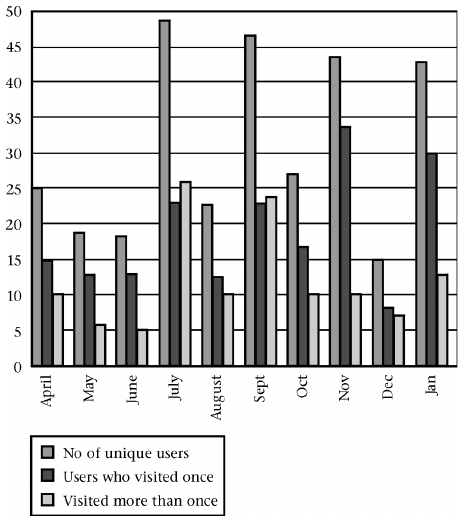
Figure 2: The EDMS user statistics for the period April 2002 to January